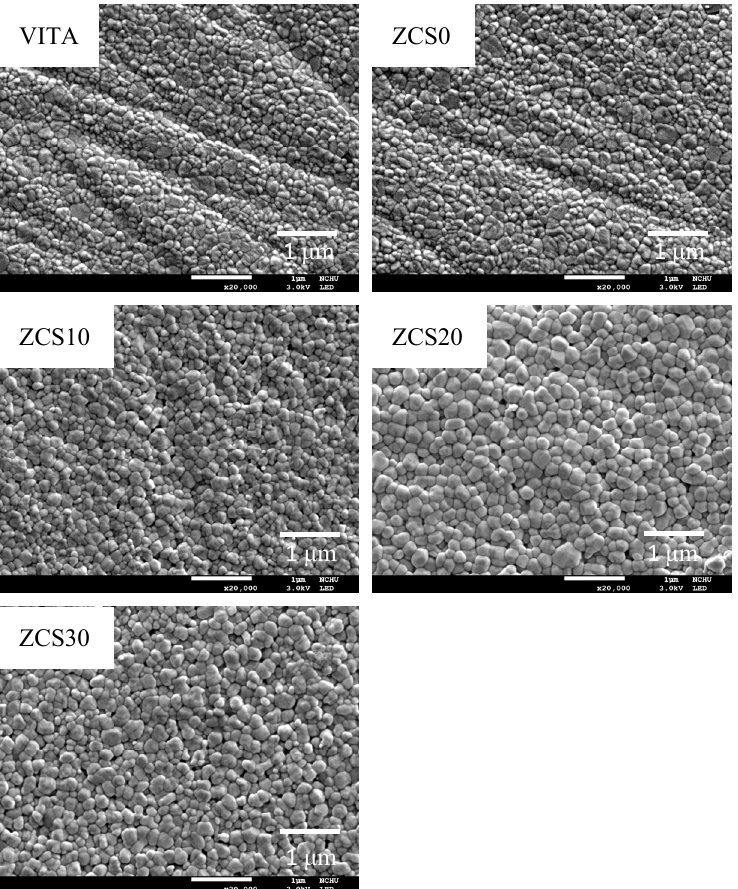
Figure 2. Surface images of all core materials after oxygen plasma treatment at high magnification (20 k×).